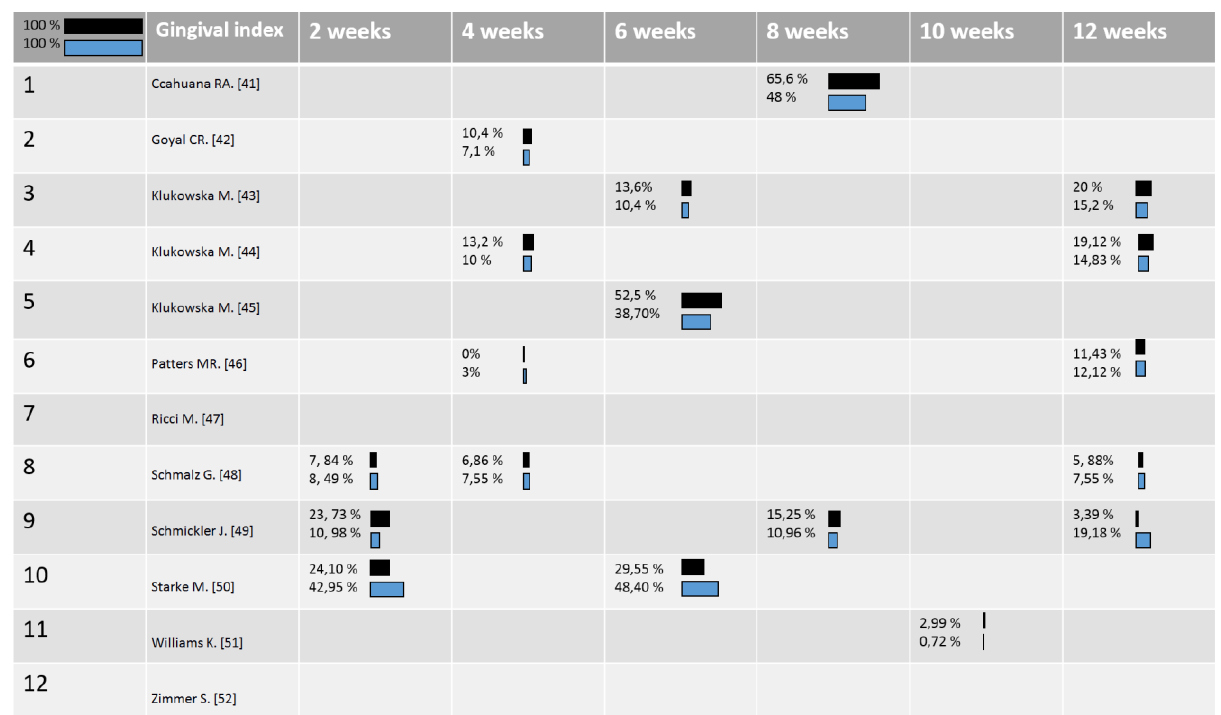
Figure 2. Gingival Index, the mean values of Gingival Index (changes) in relation to the number of patients of each study at each time-point: blue color correspond to ORHs and black corresponds to SAHs toothbrushes [41–52].